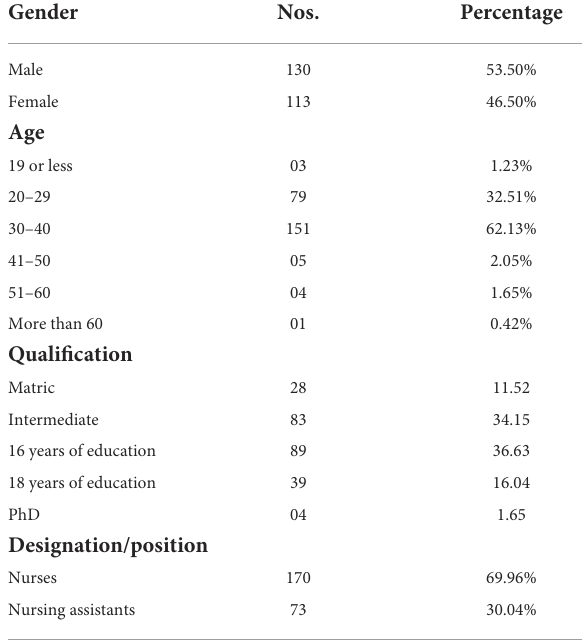
TABLE 1 Demographic representation of the